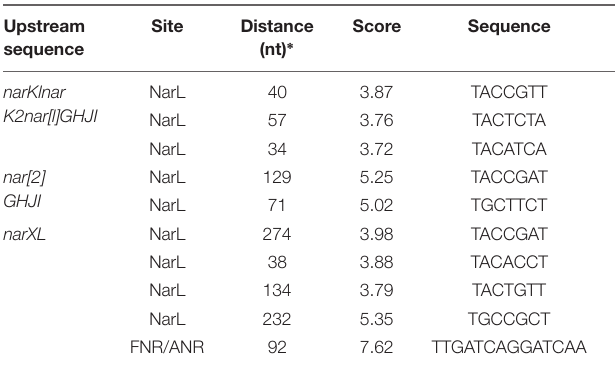
TABLE 1 | Sequences of potential NarL and ANR binding sites.